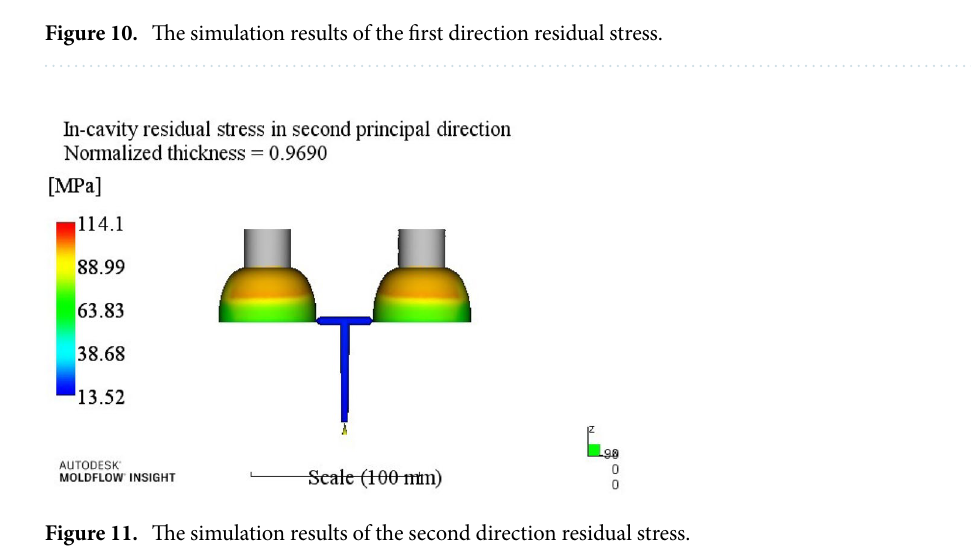
Figure 11. The simulation results of the second direction residual stress.